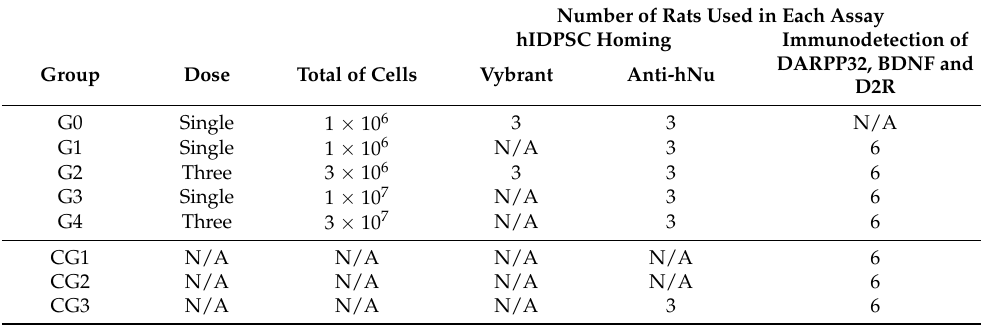
Table 1. Experimental design, describing experimental (G0–G4) and control groups (CG1–CG3), the number of cells administrated and the number of rats used in each